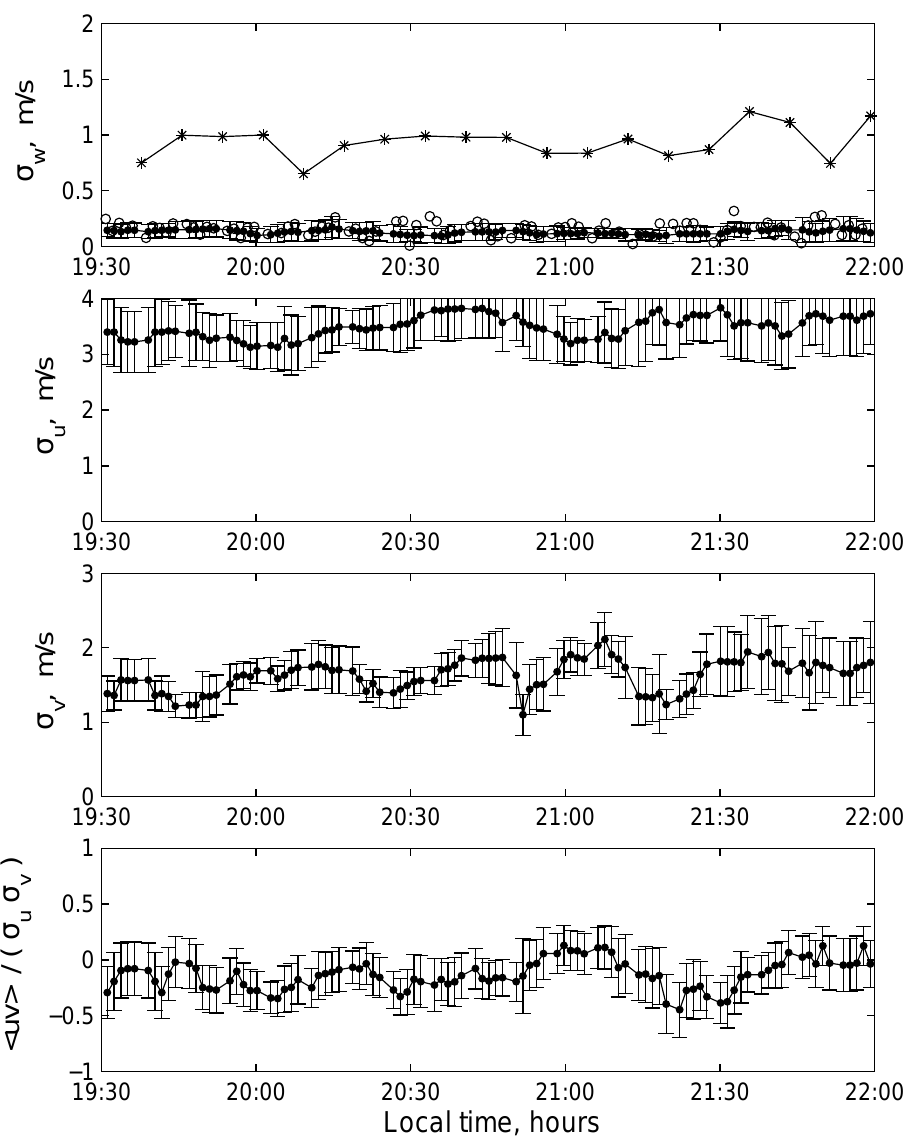
Fig. 8. Time series of turbulence characteristics on 24 April 2002 at z o = 5 . 4km. • , STARS; ◦ , HAD; ∗ , DBS.